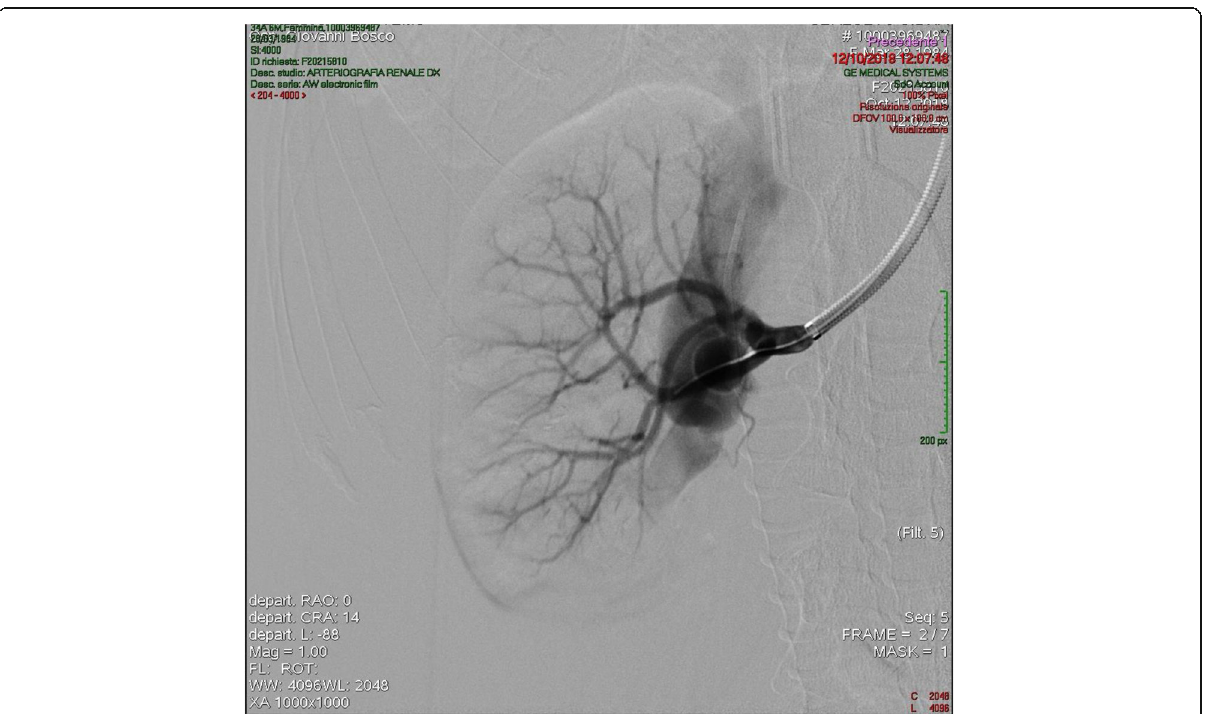
Fig. 1 Angiography performed through a 7 F 70 cm long sheath showing the renal arteriovenous fistula between the renal artery, at the hylum trifurcation point, and an extremely ectasic vein draining into the main renal vein of the right kidney. The arteriovenous communication point was 3 mm